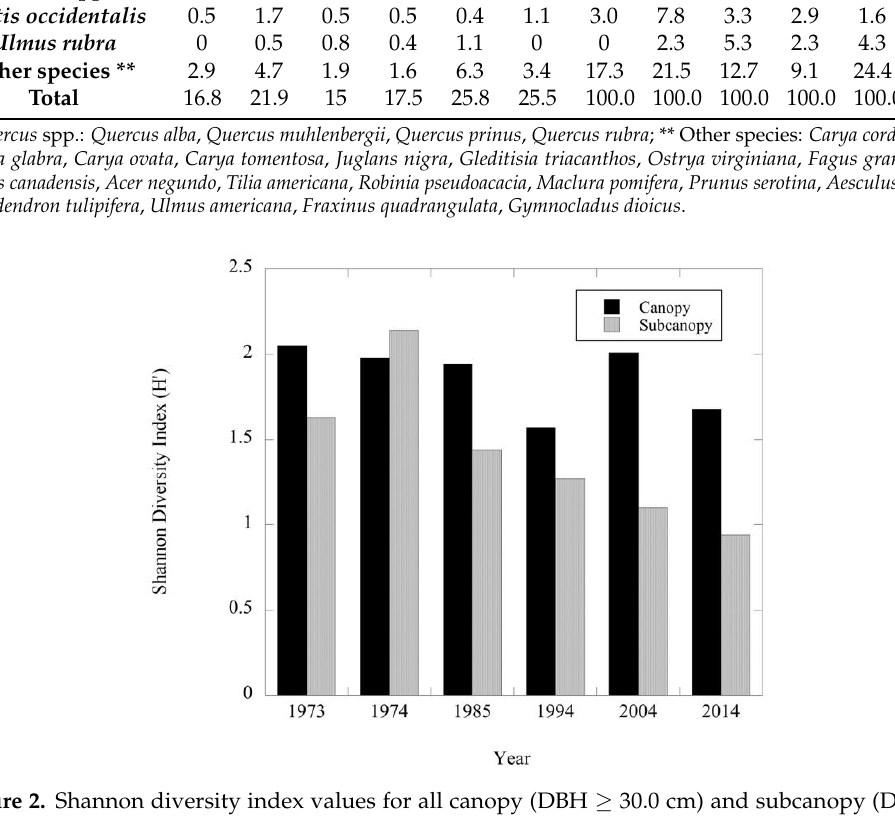
Figure 3. Density (N/ha) distribution by diameter class (DBH ≥ 10.0 cm) of Acer saccharum individuals recorded across the six sampling periods at Dinsmore Woods.